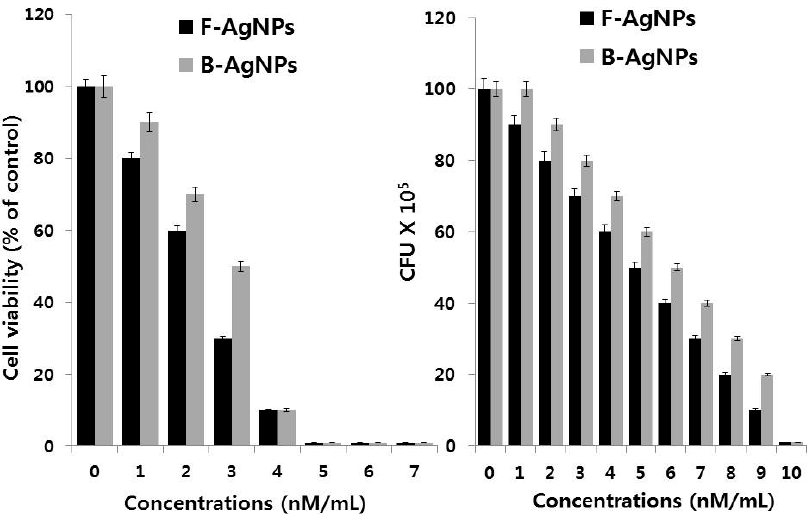
Figure 5. Differential antibacterial activity of AgNPs synthesized with Calocybe indica extracts (F-AgNPs) and the culture supernatant of Bacillus tequilensis (B-AgNPs) as reducing agents.